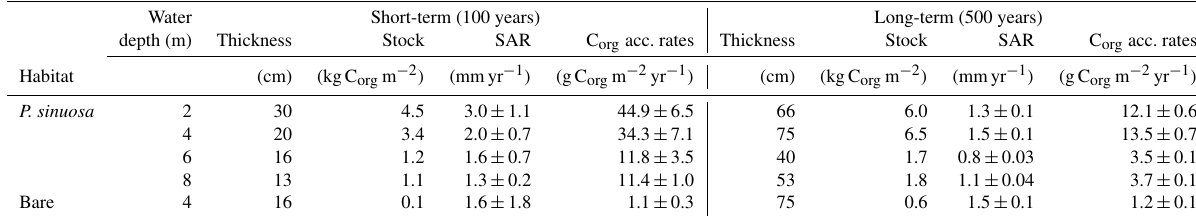
Table 3. Soil accumulation rates (SARs), C org accumulation rates and C org inventories in the seagrass cores studied (average ± standard deviation). Estimates over short-term (derived from 210 Pb dating, last 100 years) and long-term (derived from 14 C dating, last 500) periods are provided. The thicknesses of seagrass soils corresponding to 100 and 500 years are provided.